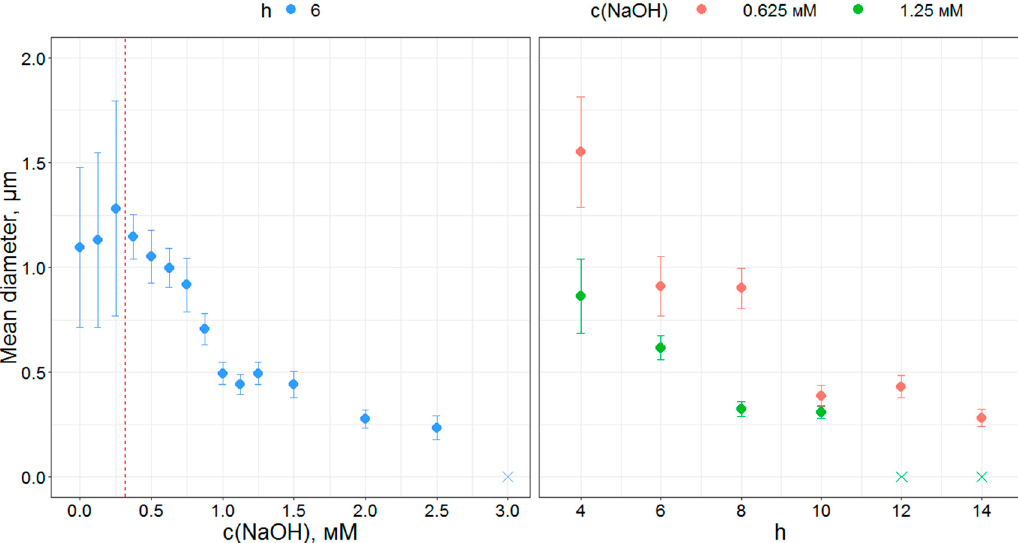
Figure 3. The changes of mean particle diameter and relative standard deviation according to SEM data with the change of NaOH concentration and hydrolysis ratio h. Crosses denote a lack of observed spherical particles.